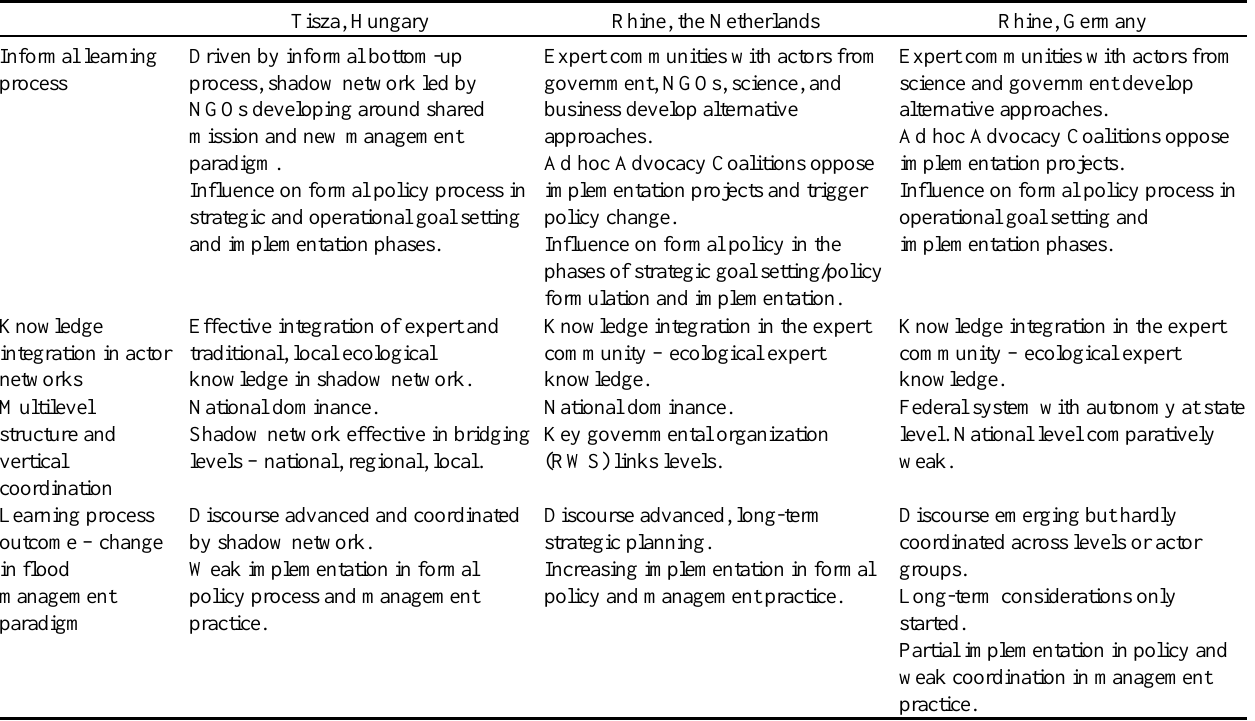
Table 3 . Overview of major case study results in comparative